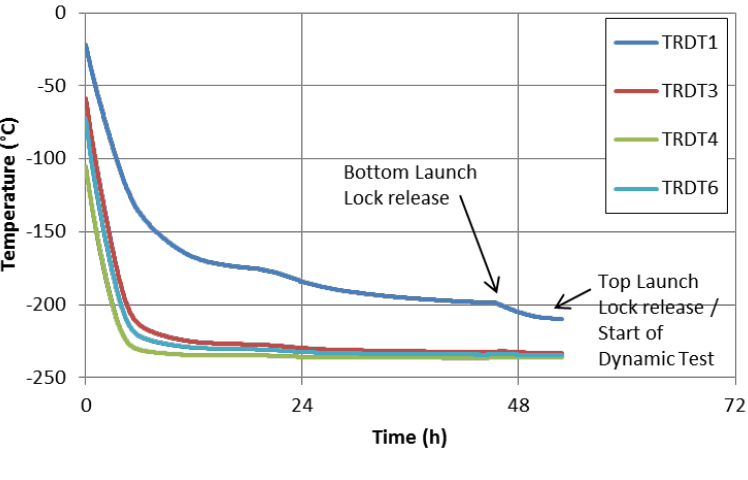
Figure 10. Cooling process: temperature vs. time.